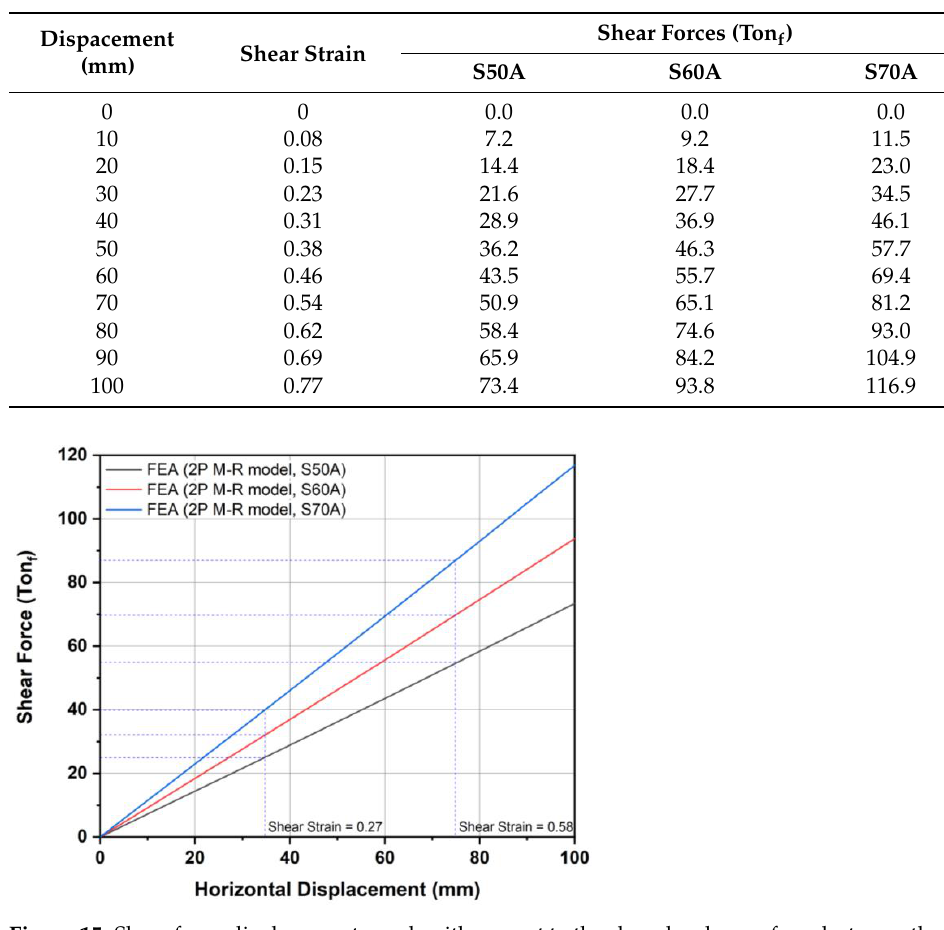
Table 10. Shear force and displacement with respect to the shore hardness of an elastomer through the numerical simulation (FEA) when the number of elements across an elastomer layer is 3.